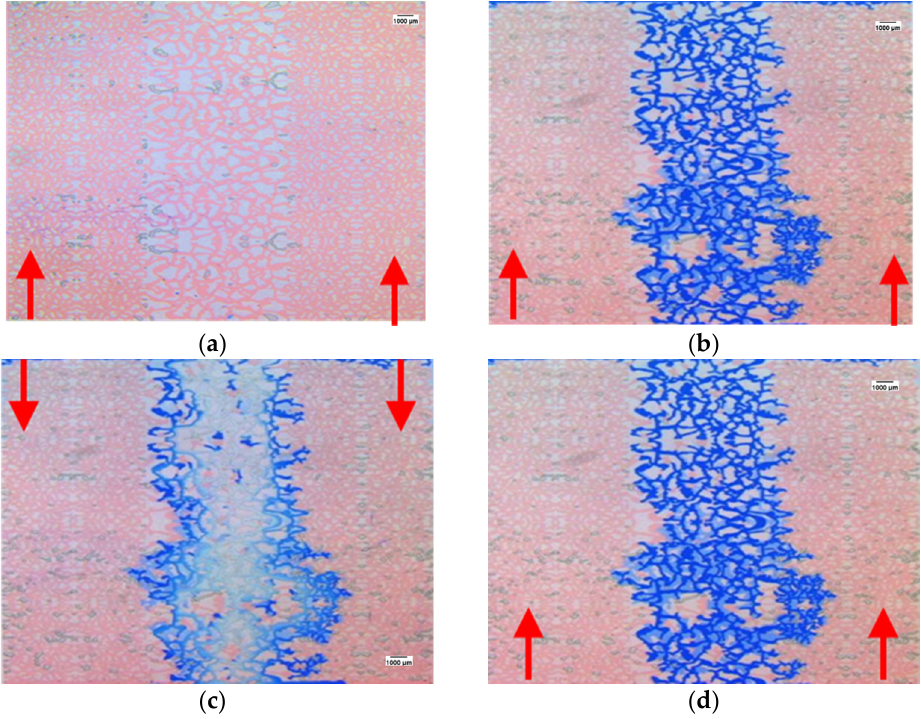
Figure 7. Heterogeneous model emulsifier injection and subsequent water invasion images: ( a ) saturated oil; ( b ) end of the first water flooding; ( c ) the emulsifier injected along the simulated “horizontal wellbore”; ( d ) end of the second water flooding.